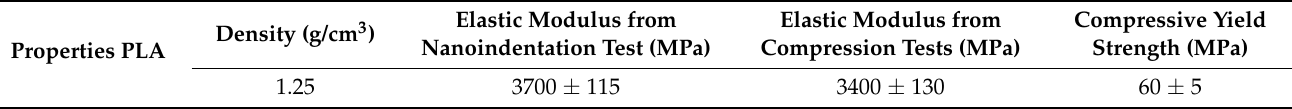
Figure 3. ( a ) Force-depth results of the nanoindentation tests of the polylactic acid (PLA) filament material and ( b ) compressive stress-strain results of 3D printed cylindrical PLA specimens. Table 3. Properties of the filament